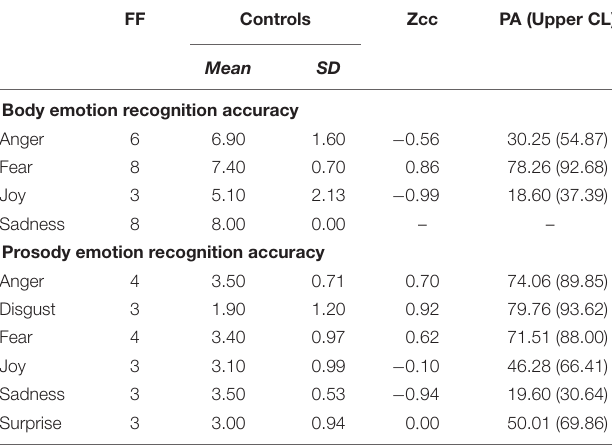
TABLE 4 | FF’s and controls’ accuracy scores in the different emotion recognition tasks.